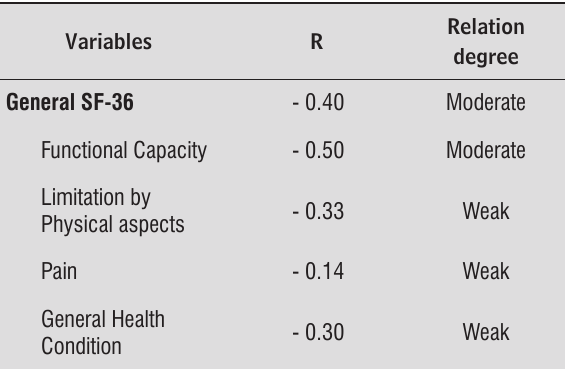
Table 3 - Correlation between quality of life and sleep- ing quality in patients with insomnia.